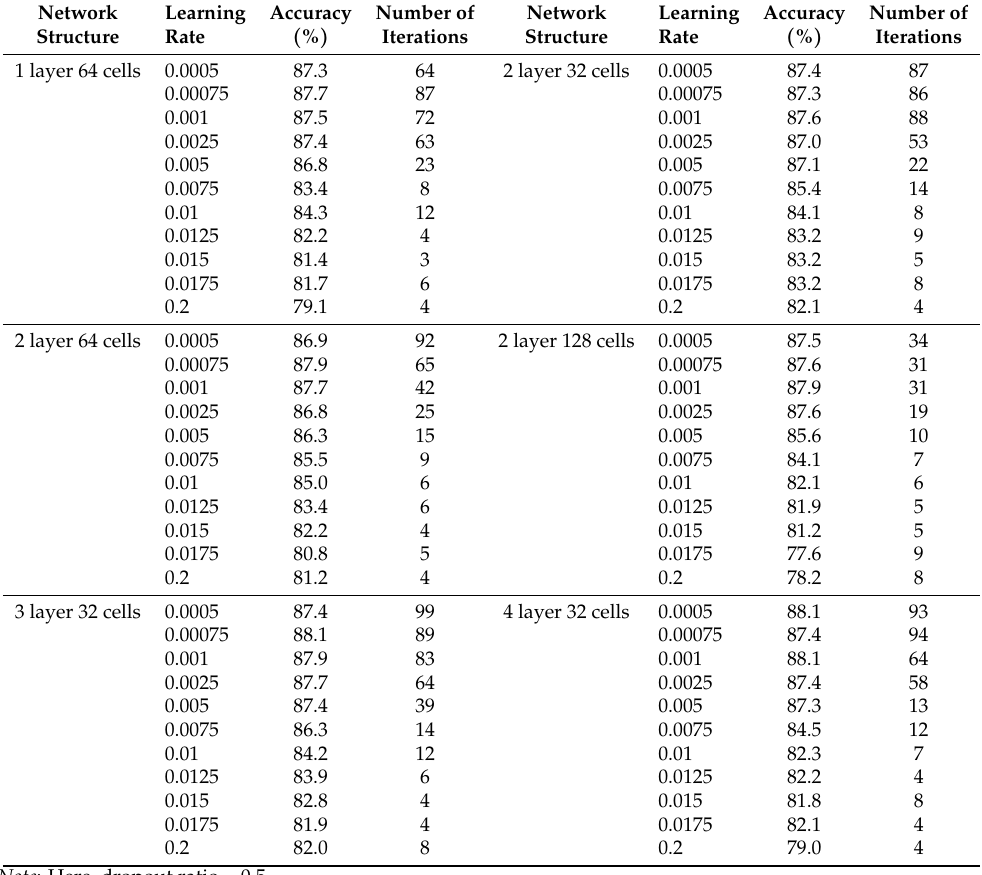
Table 2. The effect of the initial learning rate on the M 0 model’s performance (validation set).